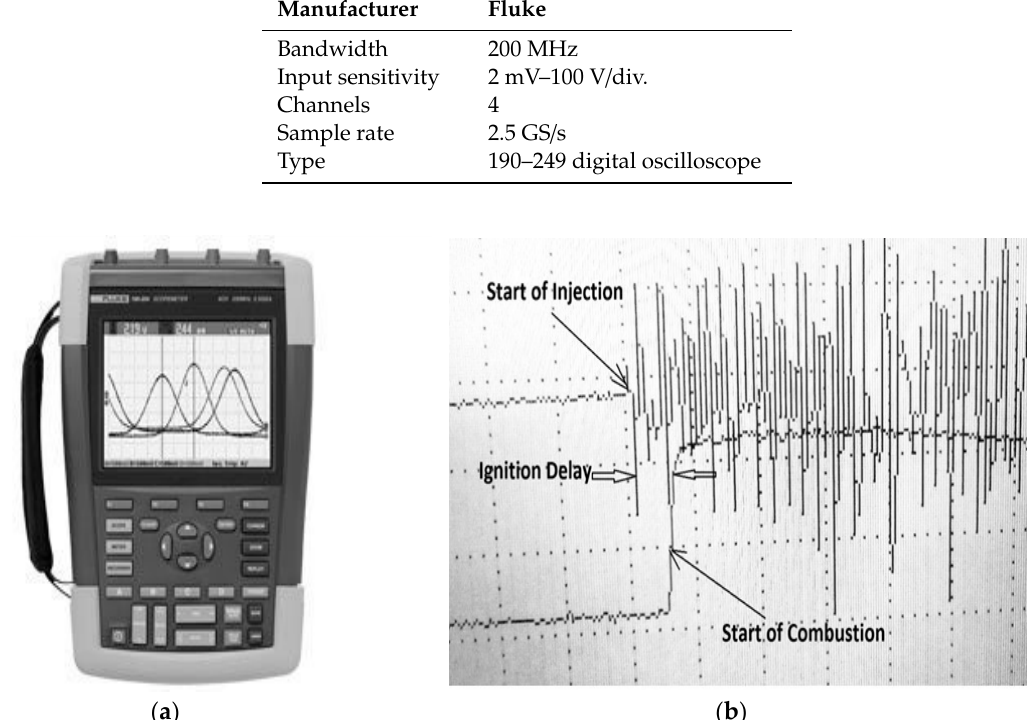
Figure 2. (a) Digital storage oscilloscope (Injection and Combustion Pulses); (b) Oscilloscope display. Figure 2. ( a ) Digital storage oscilloscope (Injection and Combustion Pulses); ( b ) Oscilloscope display.